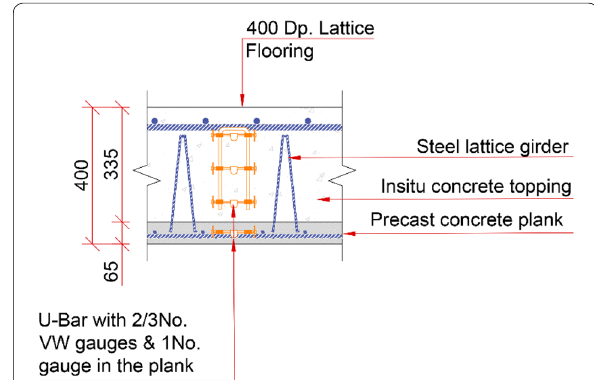
Fig. 6 Typical section showing locations of vibrating wire gauge installed in the flat slab system (Newell and Goggins